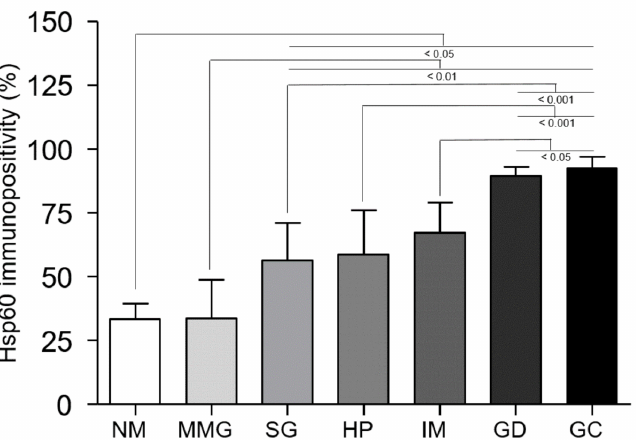
Figure 1. Histogram showing the percentage of Hsp60-positive epithelial cells in normal mucosa (NM), mild-to-moderate gastritis (MMG), severe gastritis (SG), hyperplastic polyp (HP), intestinal metaplasia (IM), gastric dysplasia (GD), and gastric adenocarcinoma (GC). Each group consisted of 10 cases. Data are presented as the arithmetic mean (AM) ± SD. Gastric dysplasia was no different from gastric carcinoma. Representative immuno- histochemical images are displayed in Figure 2.